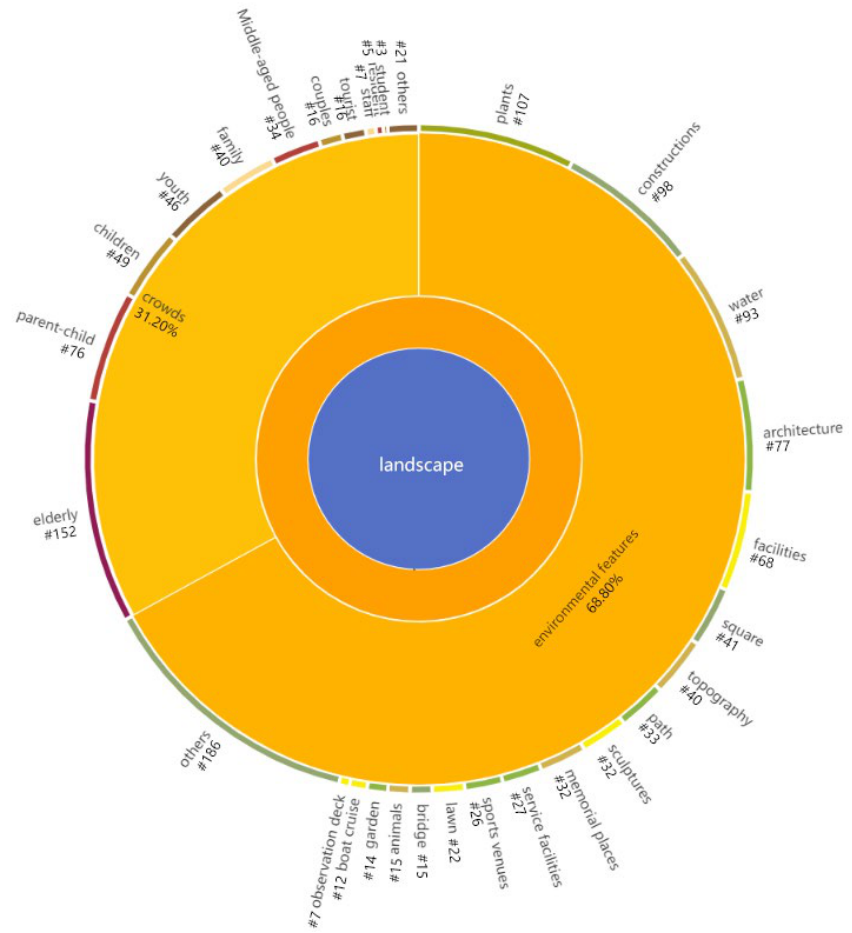
Figure 4. Landscape coding diagram.